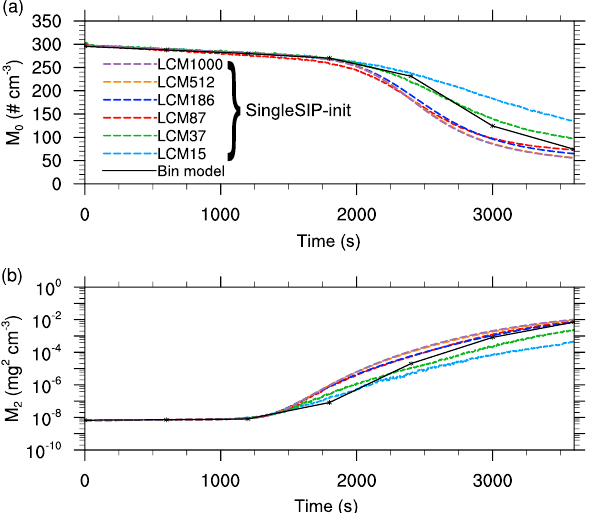
Figure 2. Moments of the mass density distribution as a function of time obtained from the single-box simulations for the “singleSIP” initialization. The black solid line denotes the solution of Wang et al. (2007). The colored dashed curves show the solution of the LCM with different numbers of superdroplets per grid box.